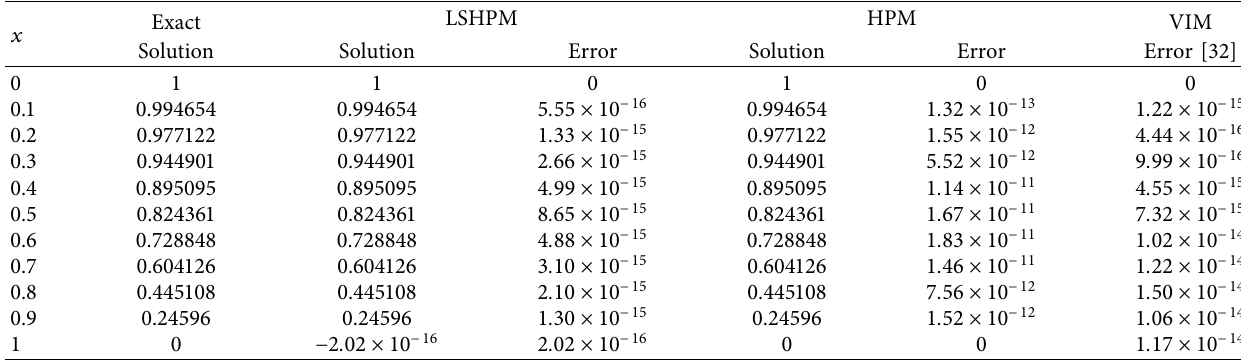
Table 11: Comparison of first-order absolute error of LSHPM with second-order HPM and VIM in Problem 11.